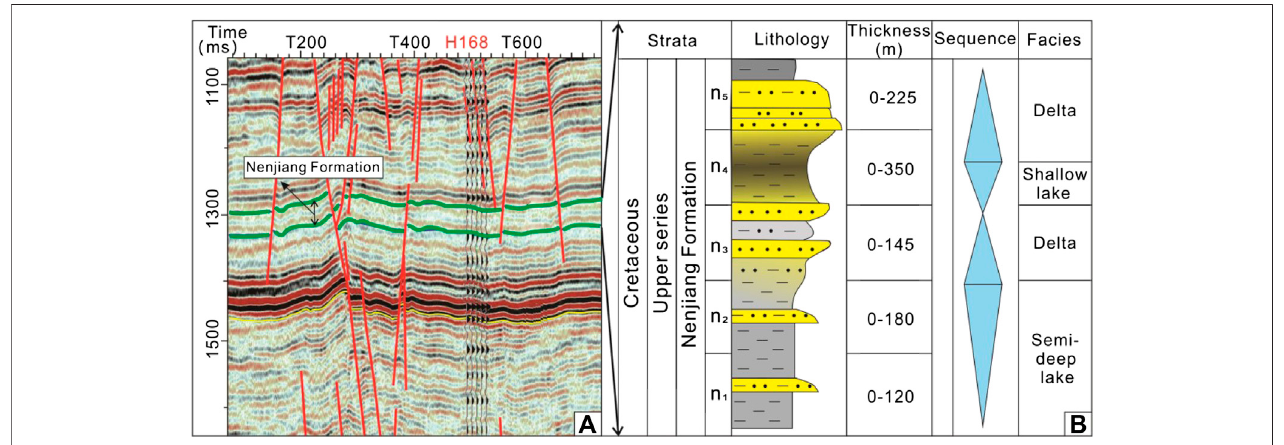
FIGURE 3 | Rock types, thickness, and major compositions: (A) lithology statistical chart; (B) sandstone thickness statistics; (C) lithologic classi fi cation of sandstone; (D) sandstone components and its lithic types.